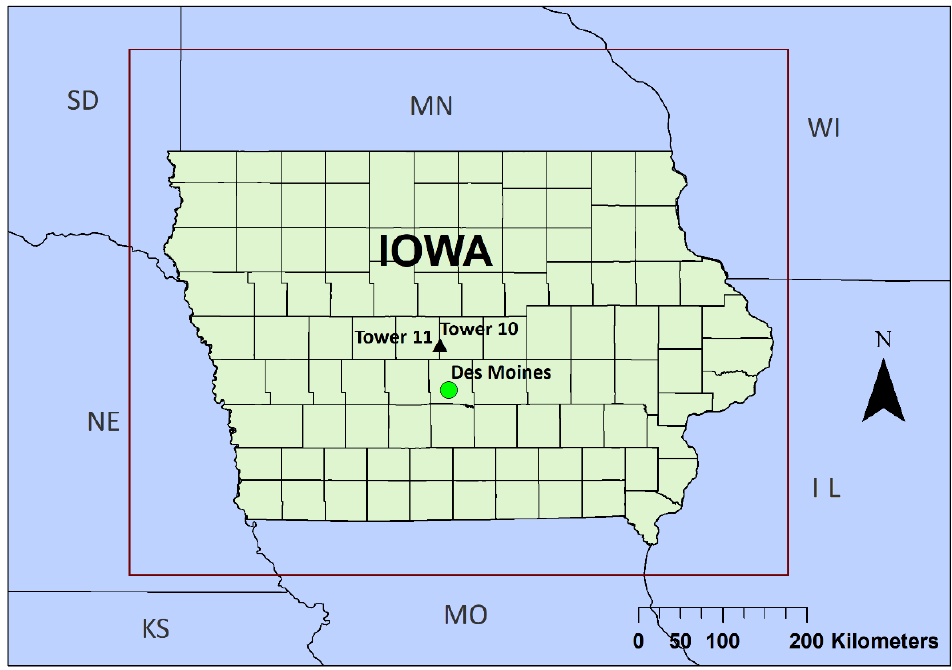
Figure 1. State of Iowa with the Iowa Flood Center (IFC) model domain and locations of two eddy covariance (EC) towers near central Iowa. The square in brown around the state of Iowa represents the study area.